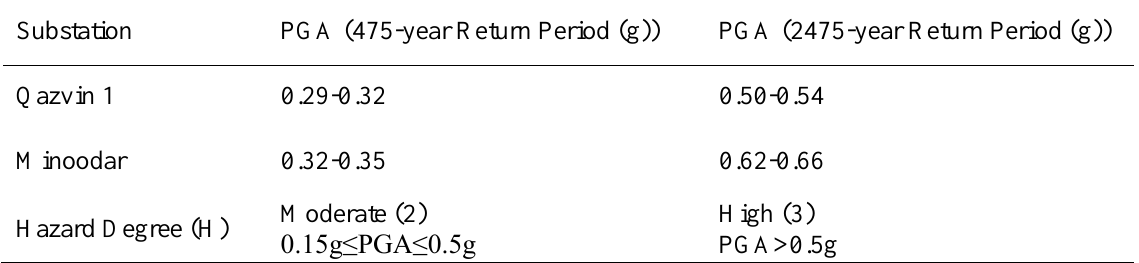
Table 6. Hazard degree for Qazvin1 and Minoodar power substations for earthquakes with